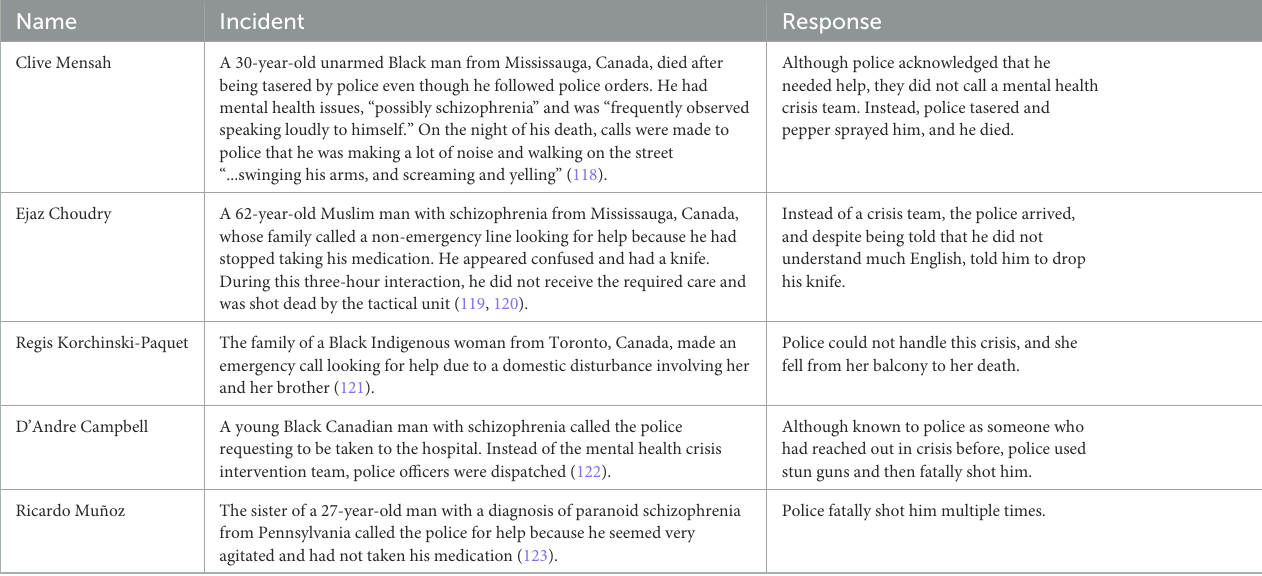
TABLE 4 Fatal examples of police interactions with racialized psychosis patients.